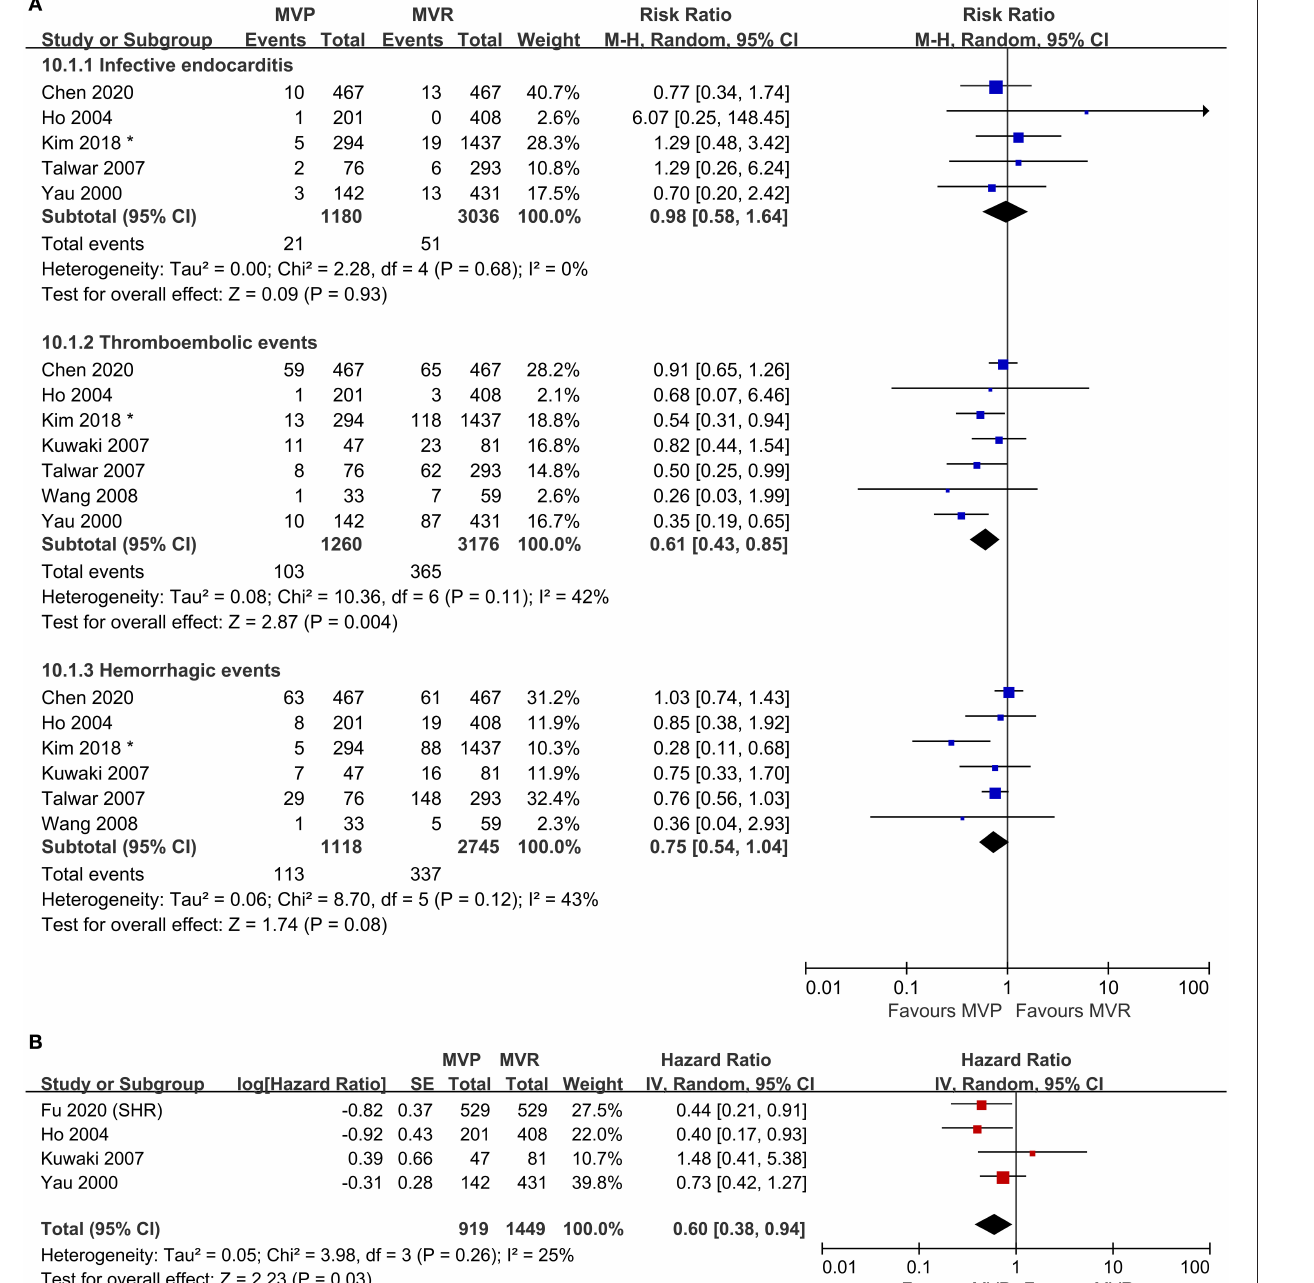
and had potential bias. The results of the sensitivity analysis were completely contrary to the original conclusion (RR 0.55; 95% CI, 0.31–0.96; P = 0.030; I 2 = 34%). Thus, we tend to consider MVP better for early mortality.